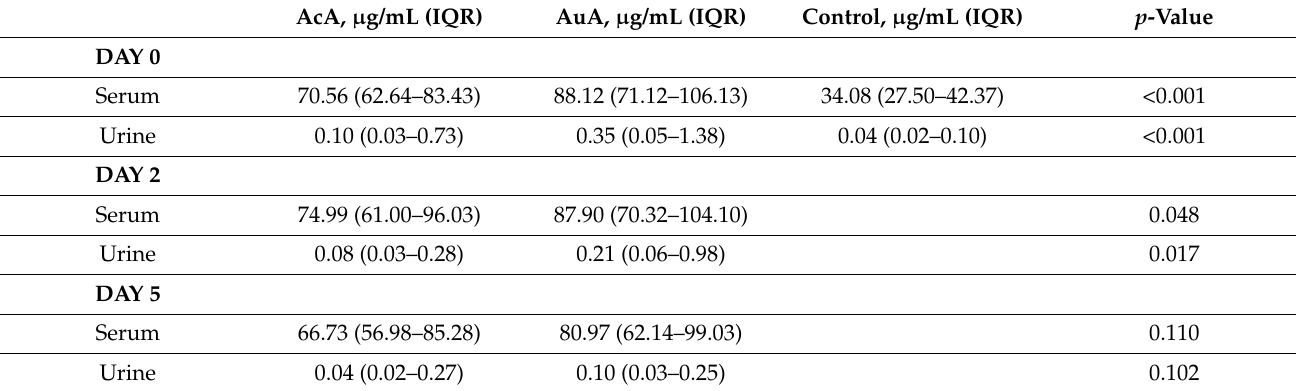
Table 2. Pre- and post-operative LRG1 levels per appendicitis status.